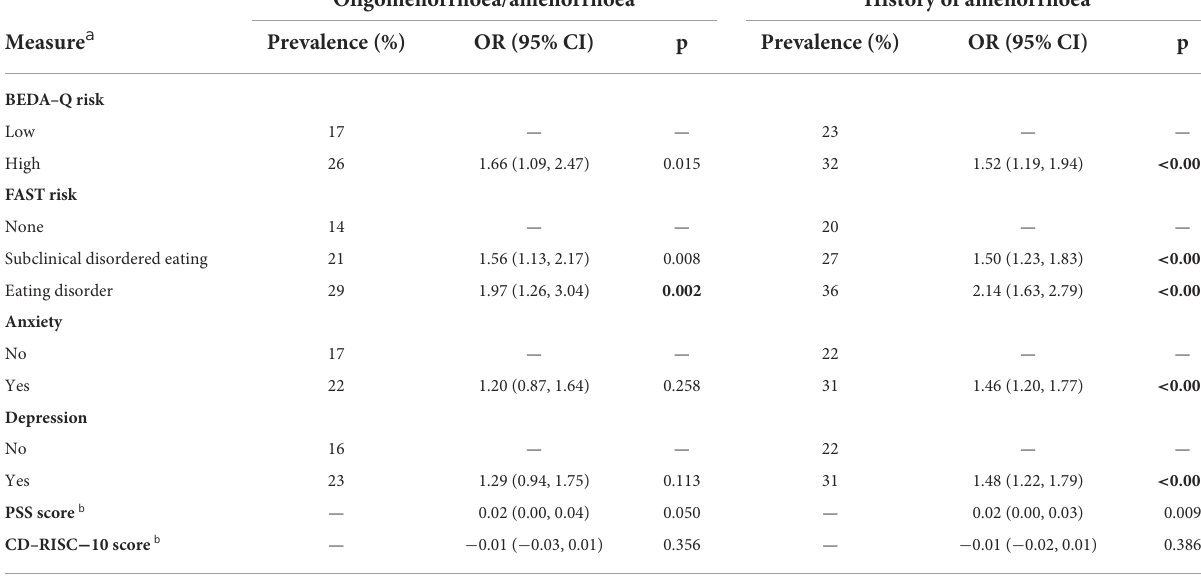
TABLE 6 Associations between risk of eating disorders and psychological well-being with menstrual function. Oligomenorrhoea/amenorrhoea History of amenorrhoea Measure a Prevalence